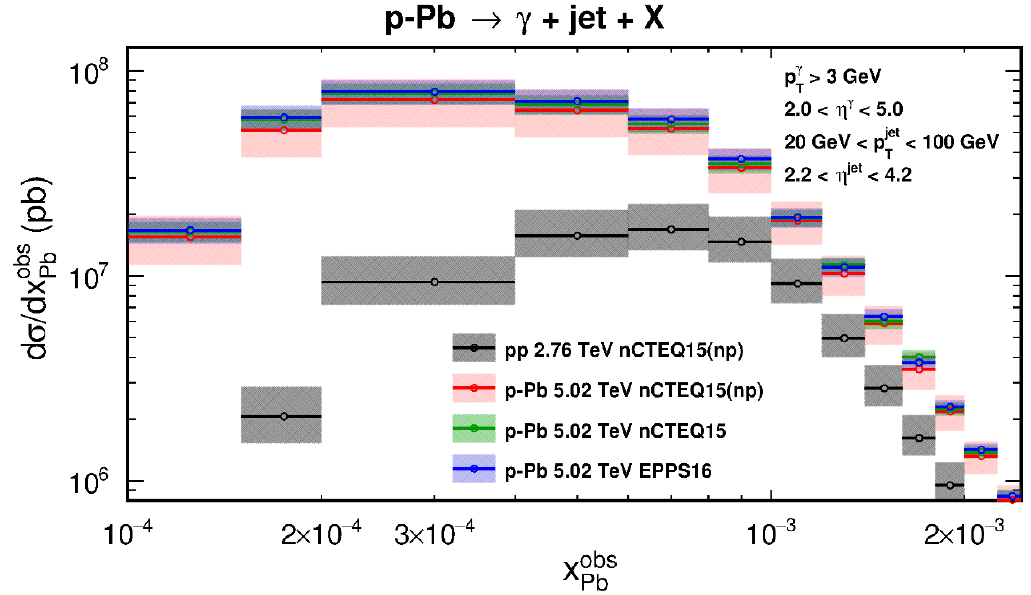
Figure 13 . Same as (cid:12)gure 12, but for Pb-p collisions.